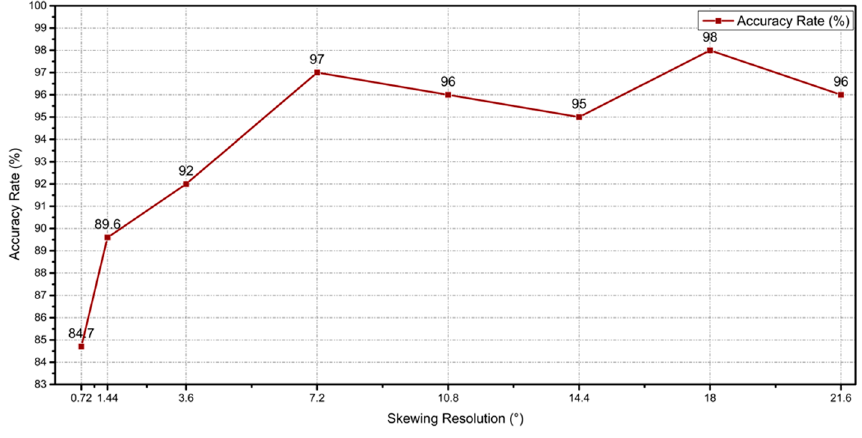
Figure 12. The recognition accuracy rate at different phase difference resolution.